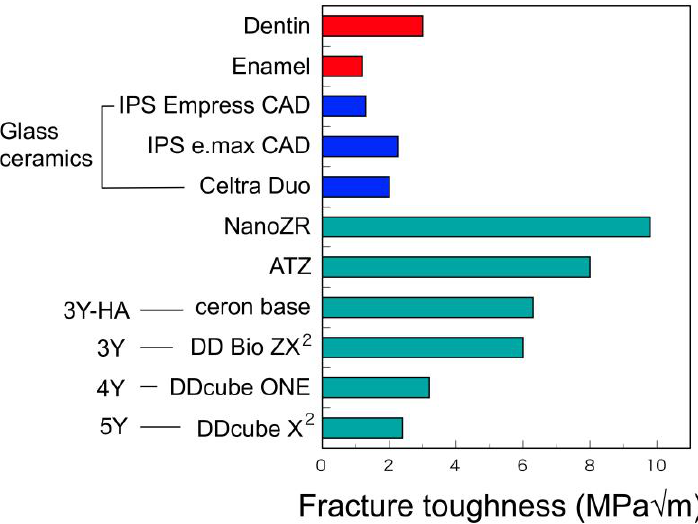
Figure 13. Fracture toughness of tooth substance and CAD/CAM materials. Adopted from manufacturers indications and Ref. [33].